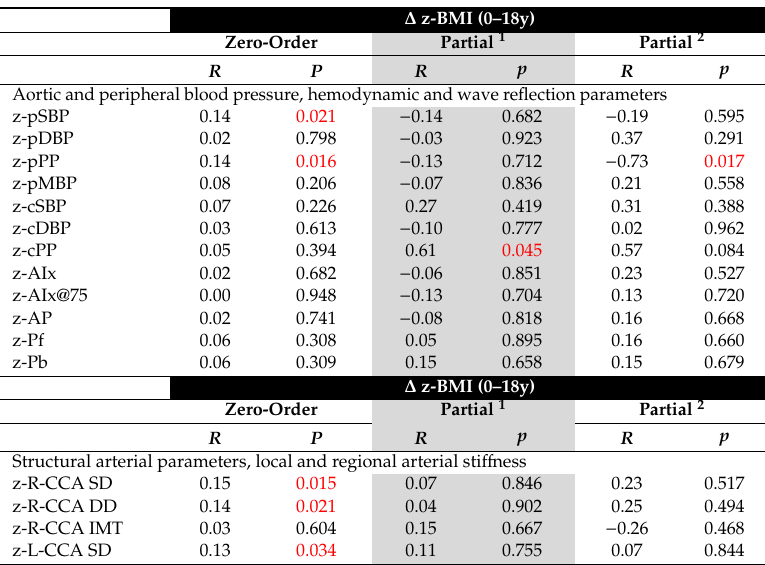
Table 7. Associations between CVz-scores and z-BMI variations between 0–18y(adolescent cohort, n = 340).